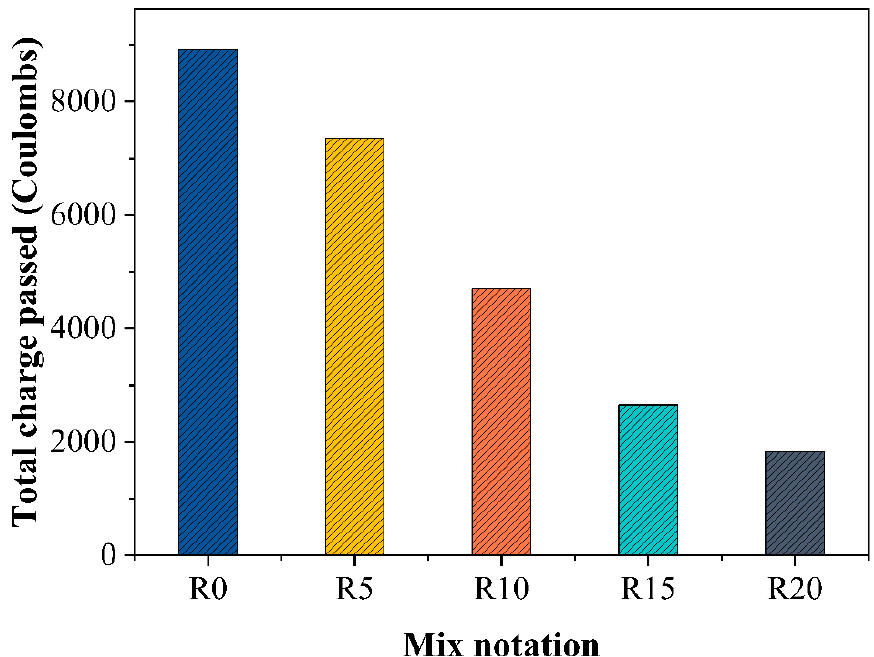
Figure 12. The total charge passed of the cement mortars during 6 h.